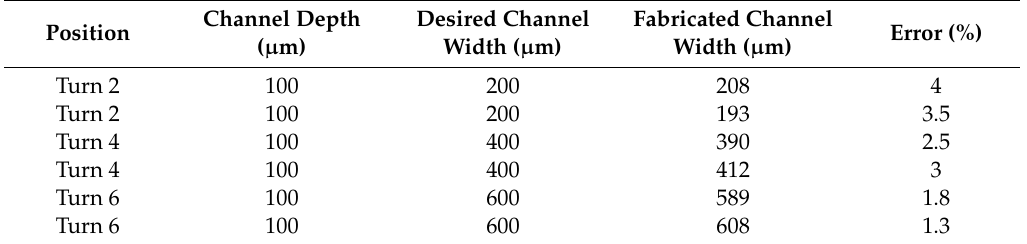
Table 1. Channel widths of molded PDMS devices can be fabricated with tolerance of less than 5%.